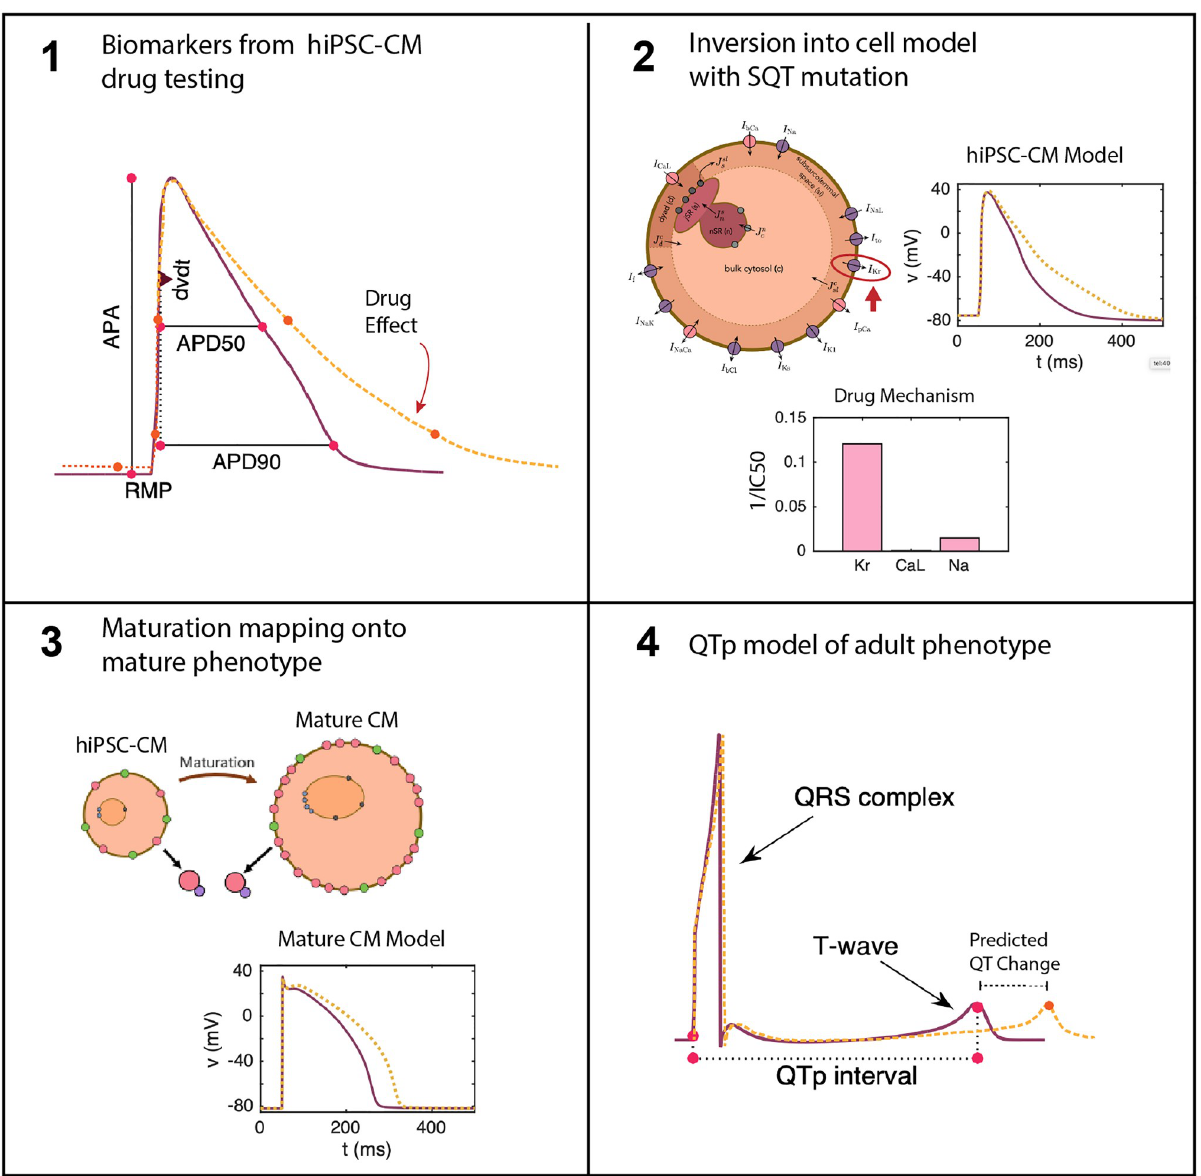
Fig 1. Illustration of the computational pipeline. 1) Biomarkers from the cardiac AP are taken from hiPSC-CMs under drug testing. 2) These biomarkers from dose escalation studies are inverted into an SQT1 model of the AP of hiPSC-CMs. Inversion into a matched model provides determination of drug effects on specific channels [23]. 3) The drug effects determined in 2 are inserted into a model of adult CMs with the same SQT1 mutation to give a prediction of drug effect in mature CMs [22]. 4) The adult CM model is converted into pseudo-ECG waveforms for prediction of QT segment changes in SQT1 patients under the estimated effect of the